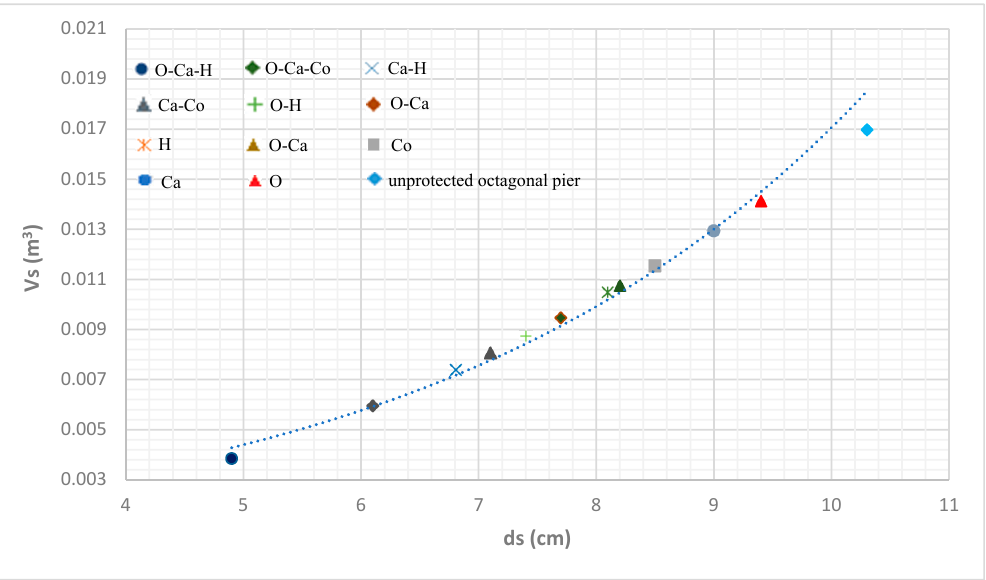
Figure 11. Volume of scour hole calculated around protected and unprotected bridge piers; dash curve is a quadratic curve ( V s = 1.6 d s 2 ) fitted over the